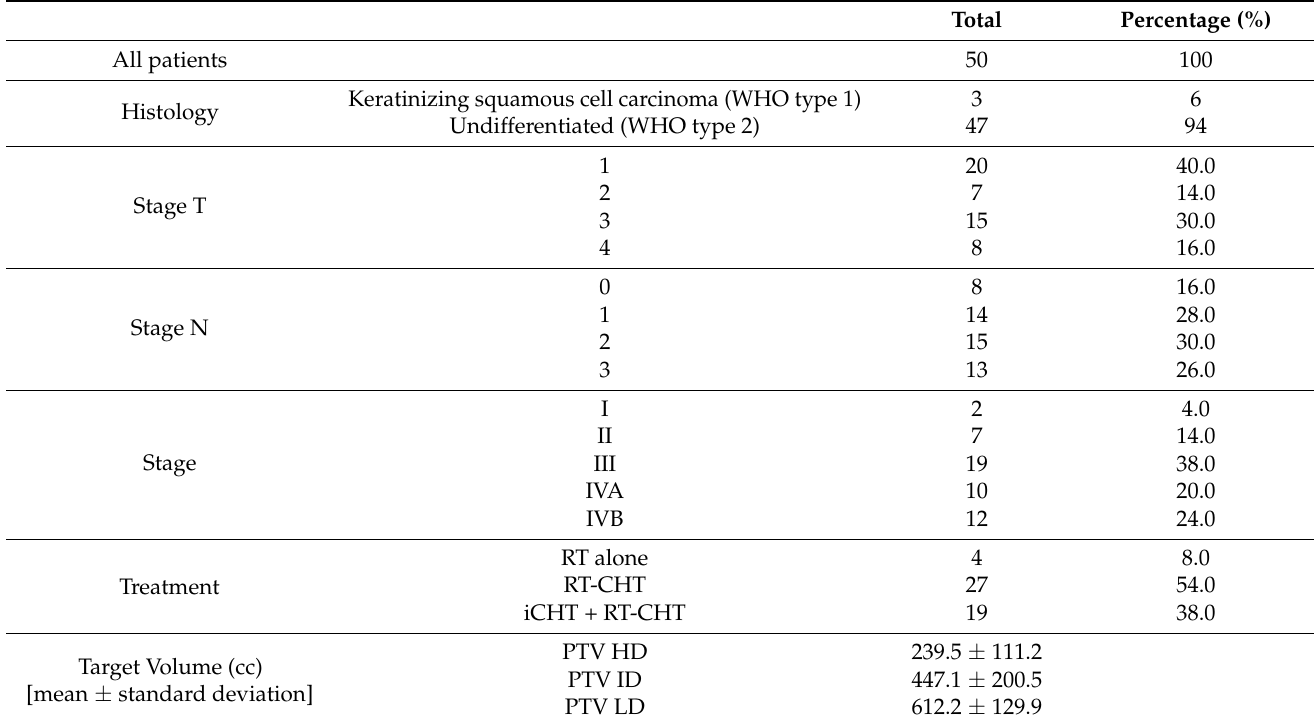
Table 2. Clinical and treatment–related characteristics of the 50 patients included in the study.